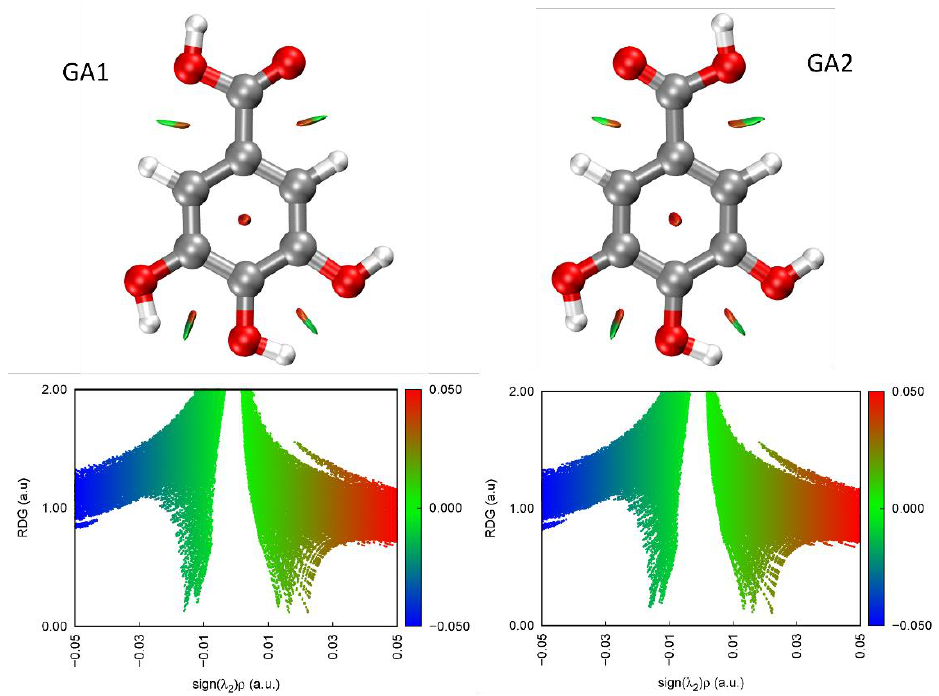
Figure 3. The figure shows the results of the non-covalent interaction (NCI) analysis applied to conformers GA1 and GA2. The equilibrium structures calculated at the B3LYP-D3/6-311++G(2d,p) has been considered.